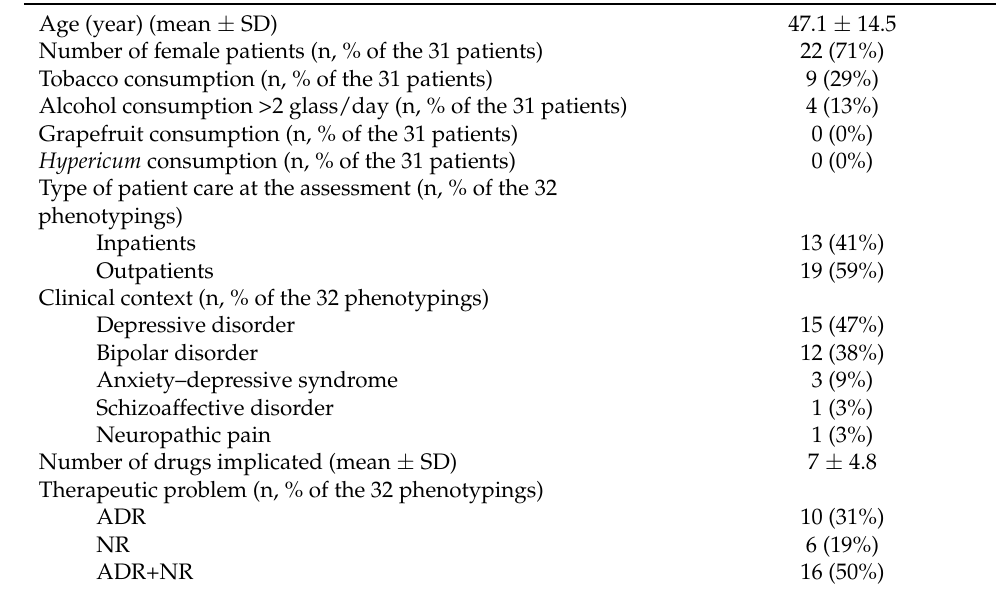
Table 1. Population and phenotyping